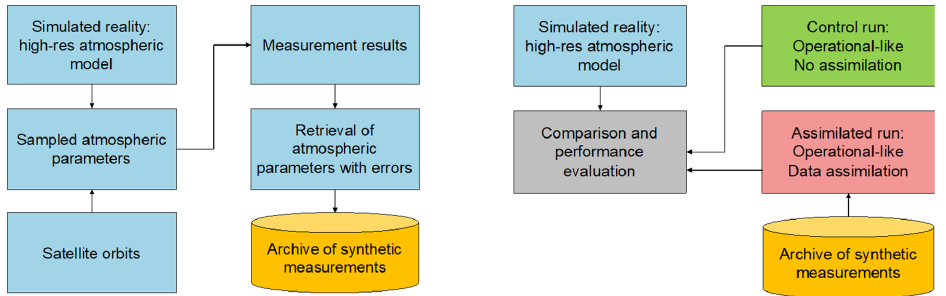
Figure 14. The Observing System Simulation Experiment (OSSE) approach for generating synthetic measurements (phase 1 in left panel) and for the analysis of the assimilation impact on the model forecasts (phase 2 in right